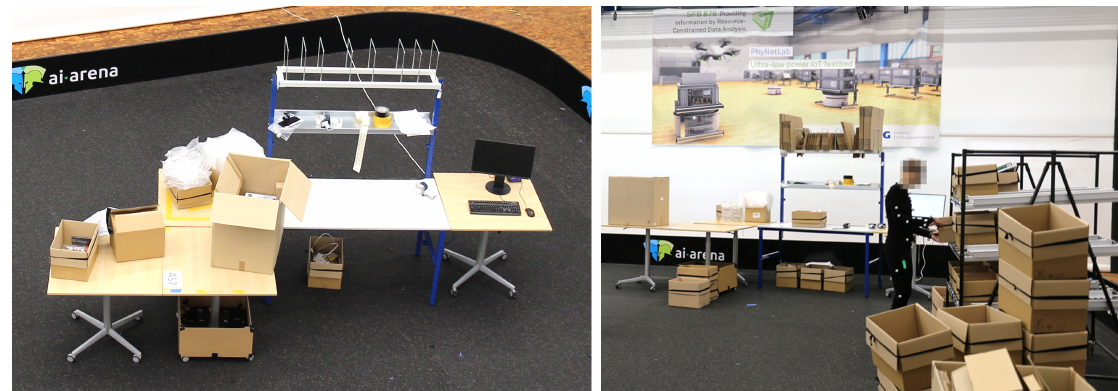
Figure 7. Physical laboratory set-up of logistics Scenario 3—real warehouse packaging work